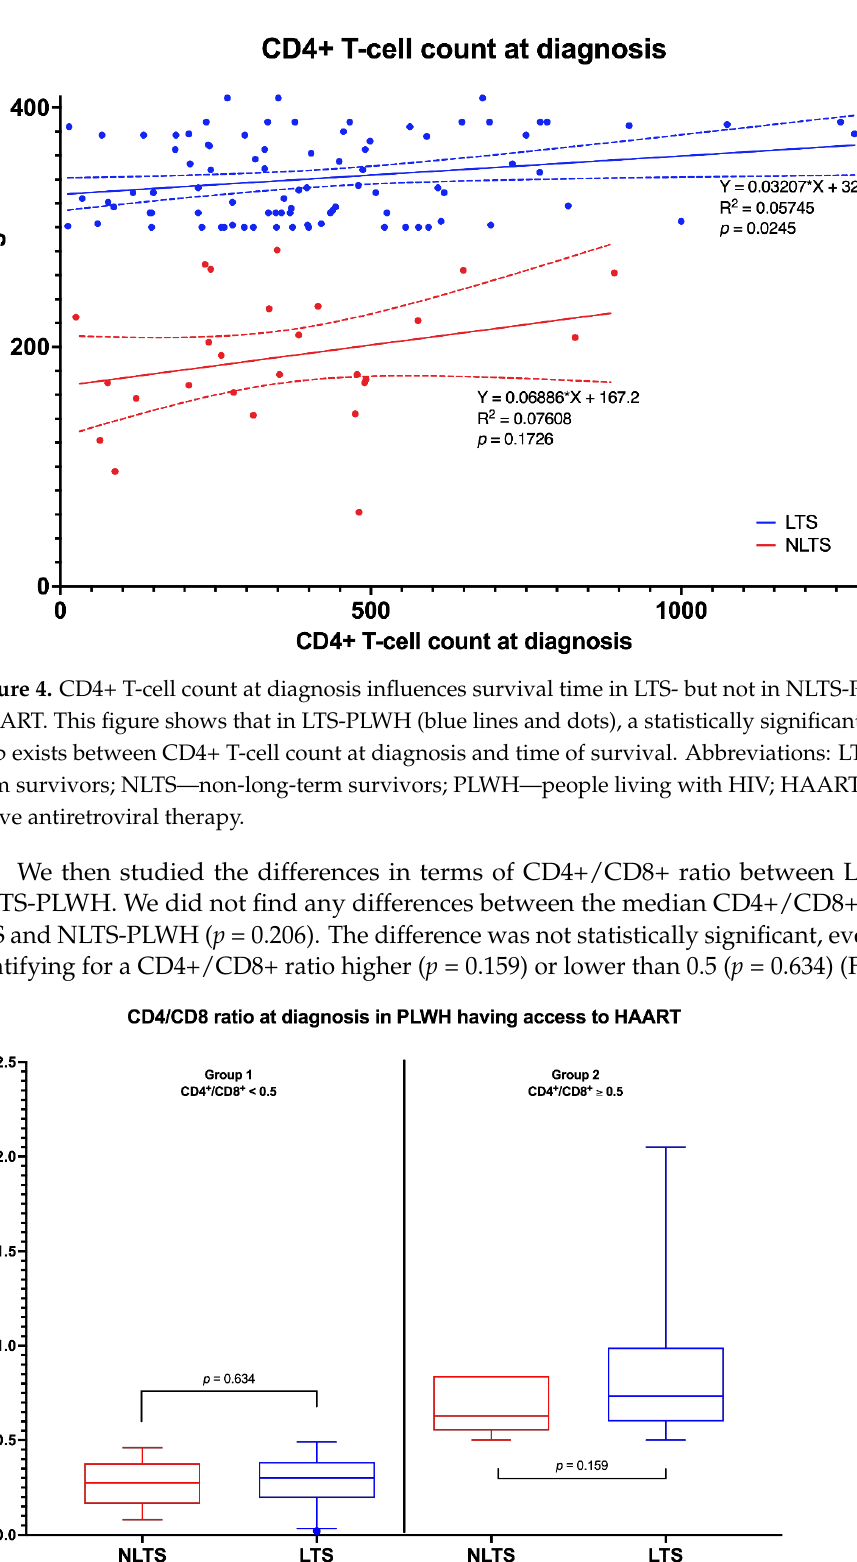
Figure 5. CD4+/CD8+ ratio at diagnosis in PLWH who had access to HAART. This figure shows that at diagnosis, there was no statistically significant difference between NLTS-PLWH (red) and LTS- PLWH (blue) in terms of CD4/CD8 ratio when stratifying by ratio higher or lower than 0.5. Abbre- viations: PLWH—people living with HIV; HAART—highly active antiretroviral treatment; NLTS— non-long-term survivors; LTS—long-term survivors.